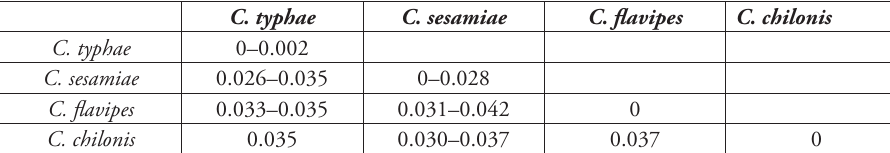
Table 3. Minimum and maximum divergence of COI sequences between all pairs of